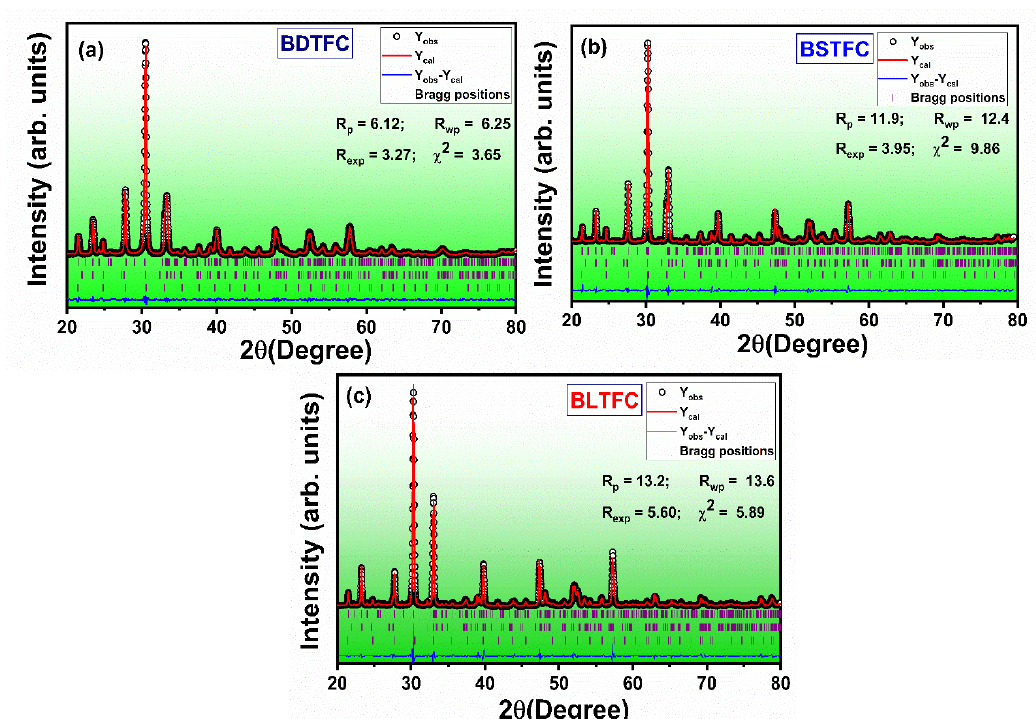
Figure 1. ( a – c ) XRD patterns of the BDTFC, BSTFC, and BLTFC ceramics.